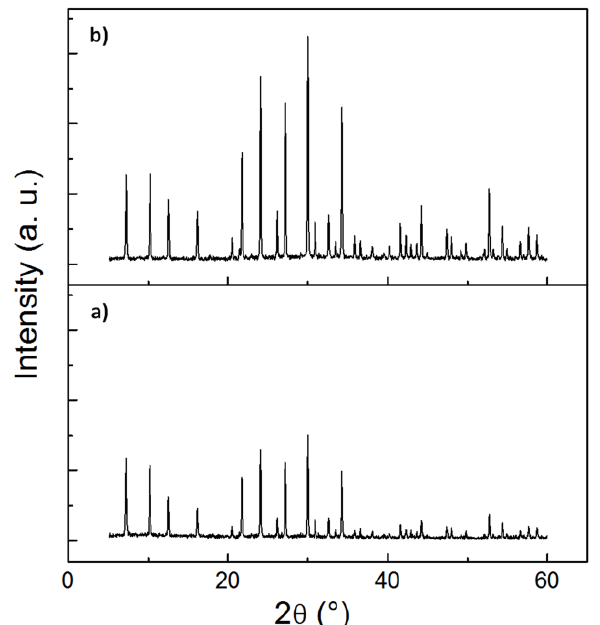
Figure 3. X-ray diffraction patterns of the nanosized zeolites, methylcellulose removed from zeolite matrix by simply washing and calcination: ( a ) NZ040 after washing and ( b ) NZ040 after calcination at 773 K for 6